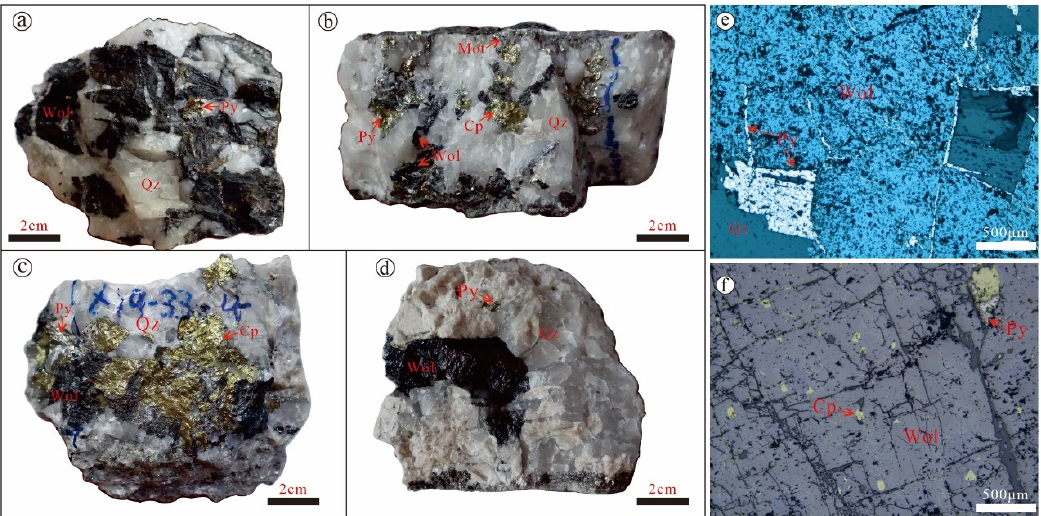
Figure 4. Photographs ( a – d ) and photomicrographs ( e – f ) of the Xingluokeng pyrite and wolframite samples. ( a – c ) are the pyrite samples used for He-Ar isotopic test, and the figures show that pyrite and other sulfides coexisted with wolframite; d is the wolframite sample used for He-Ar isotopic test, the figure show that wolframite was better crystallized; ( e – f ) are photomicrographs of pyrite and wolframite, which show that pyrite and wolframite were formed at the same metallogenic stage or slightly later than wolframite. Py = pyrite, Wol = wolframite, Cp = chalcopyrite, Mot = molybdenite, and Qz = quartz. Table 1. Location and description of samples used for this study.